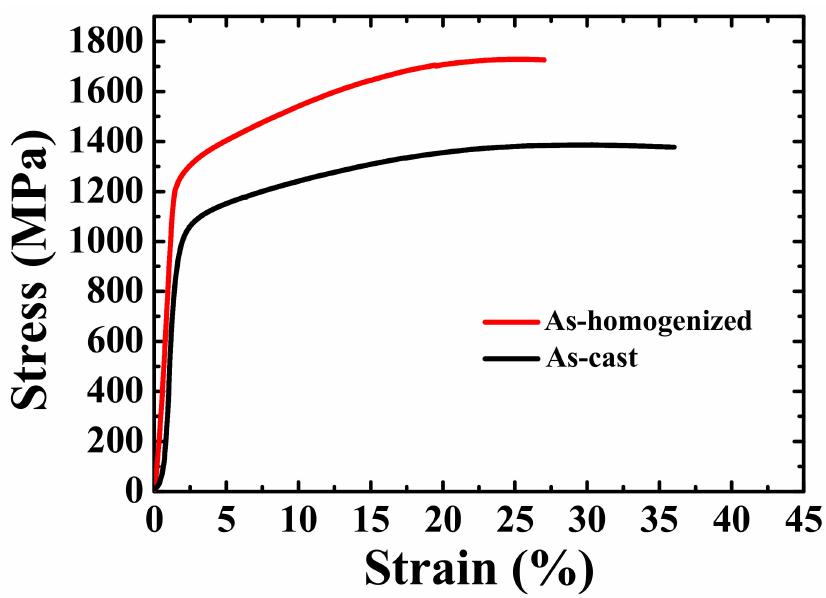
Figure 4. The compressive stress–strain curves of the as-cast and as-homogenized TiZrNbTa